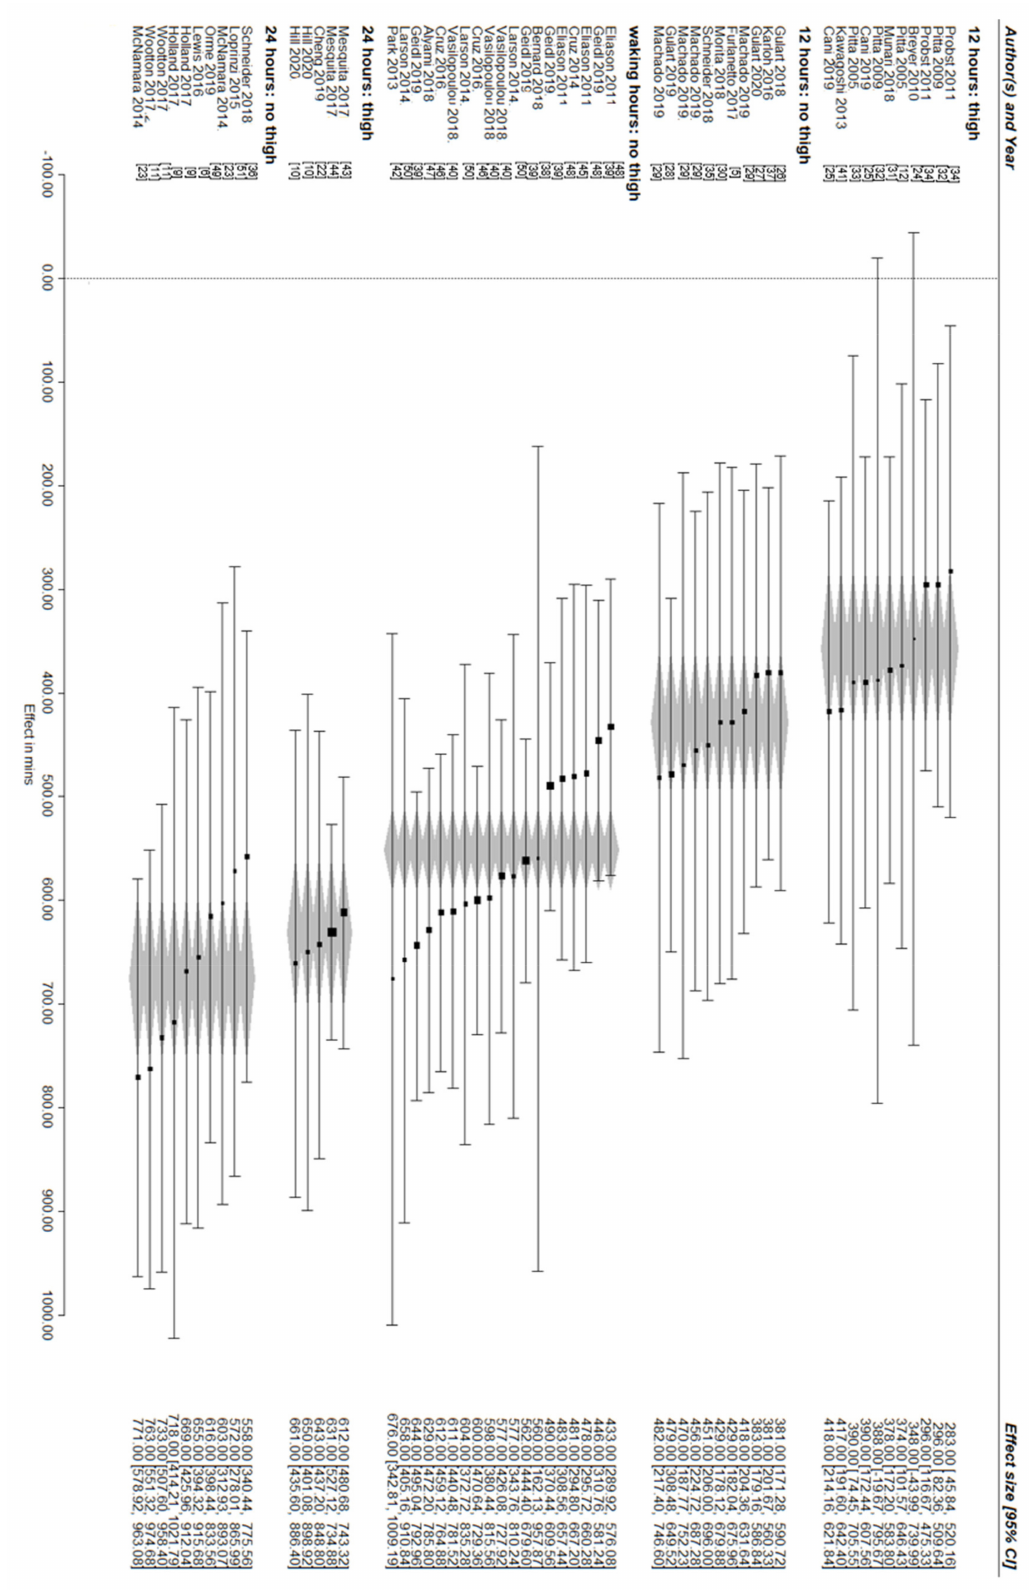
Figure 2. Forest plot of estimates of sedentary time with studies grouped according to wear time and monitor type. Data are represented as mean [95% confidence interval]. The grey diamonds represent the pooled 95% confidence interval for that